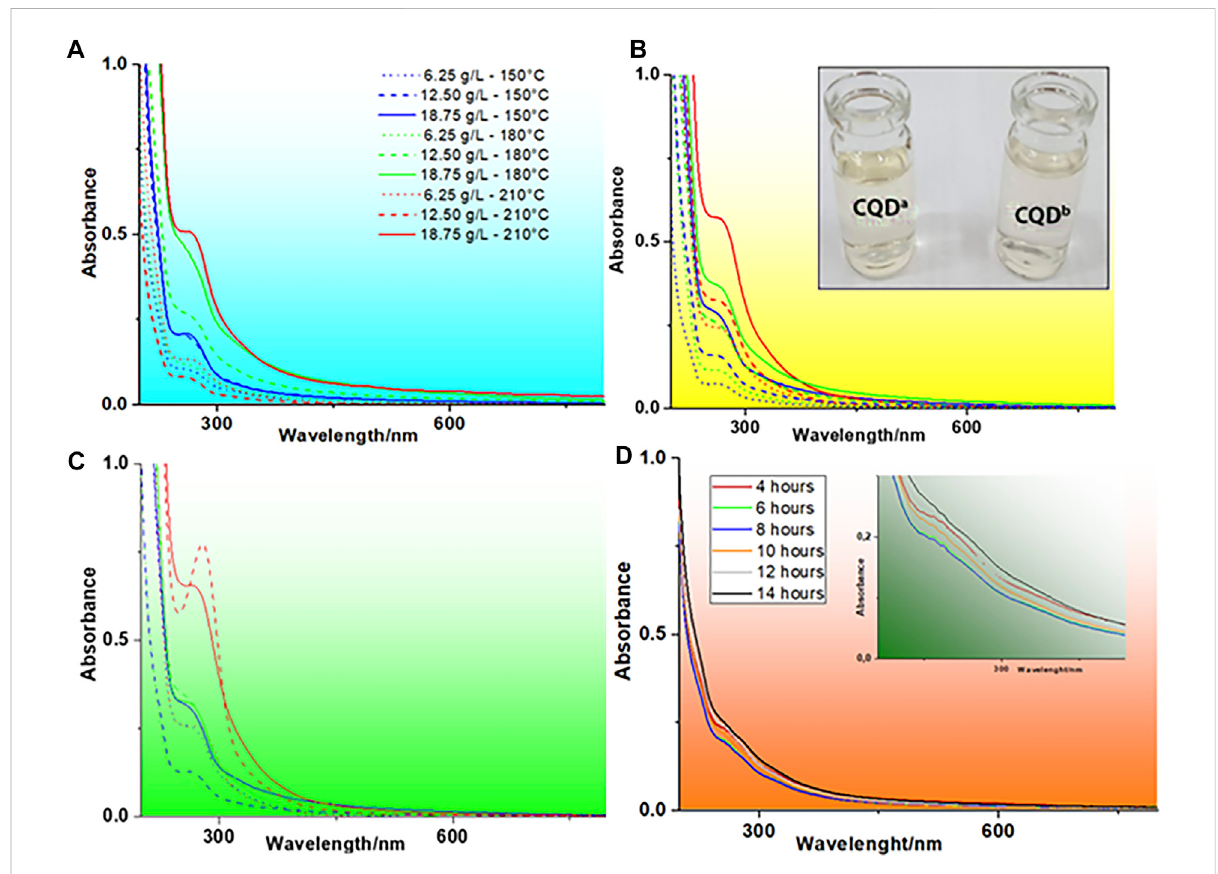
FIGURE 2 UV-Vis absorption spectra of CQDs a at different concentrations and temperatures for microwave synthesis times of (A) 8 min, (B) 15 min, and (C) 30 min (D) UV-Vis absorption spectrum of CQDs b at different autoclave synthesis times (using constant temperature and concentration), with absorbance magni fi cation in the range of 220 – 380